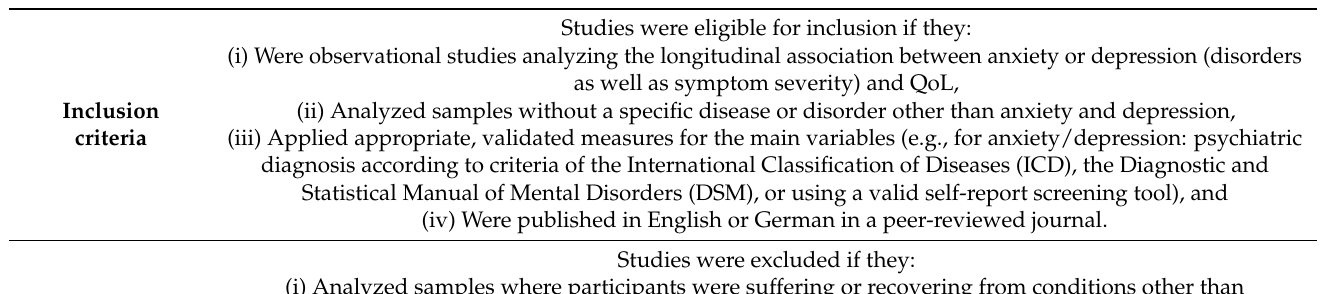
Table 1. Study selection